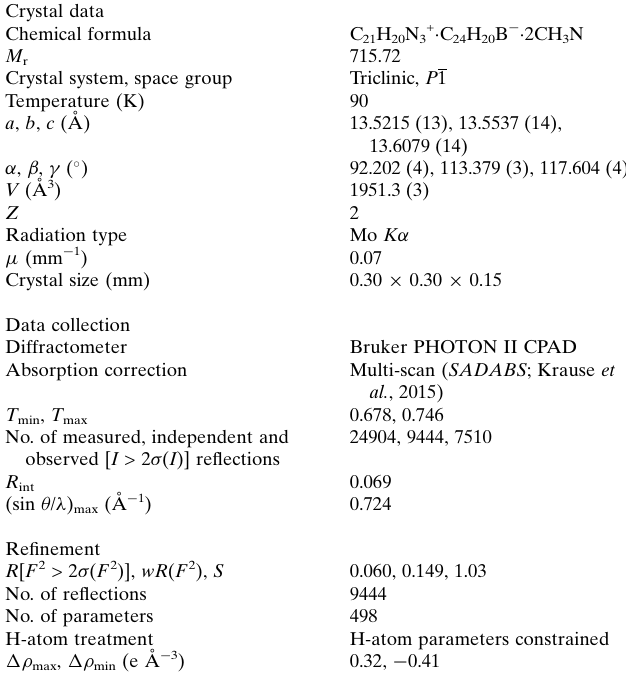
Table 2 Experimental